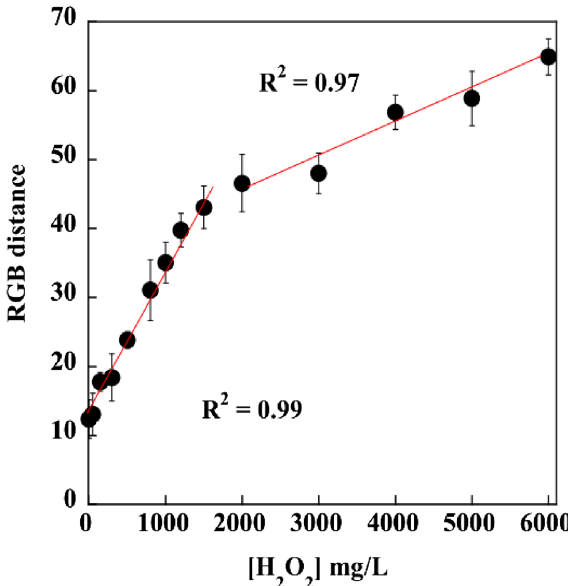
Figure 7. Calibration curve plotting the signal intensity of color detected by P-AgNPs-100 integrated with the ImageJ software versus the H 2 O 2 concentration.